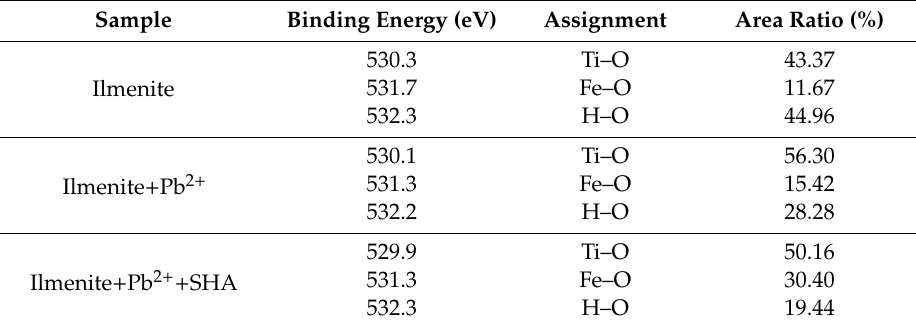
Figure 9. High-resolution XPS spectra of ilmenite, before and after Pb 2 + and SHA treatment ( a : Fe2p3 / 2; b : Ti2p3 / 2; c : Pb4f7 / 2; d : O1s). Table 3. O1s parameters on ilmenite surfaces treated with different flotation reagents.